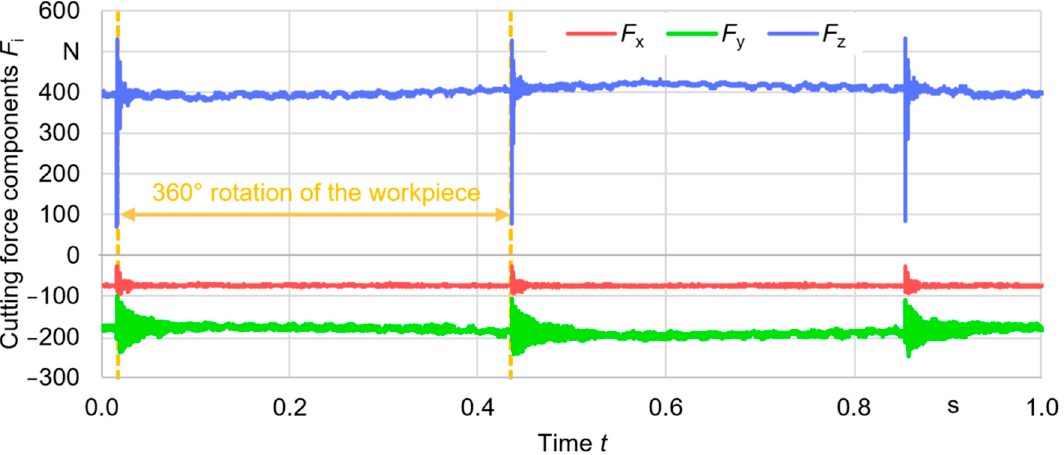
Figure 7. Sensitivity of the cutting force components in x-, y- and z-direction on a material defect.